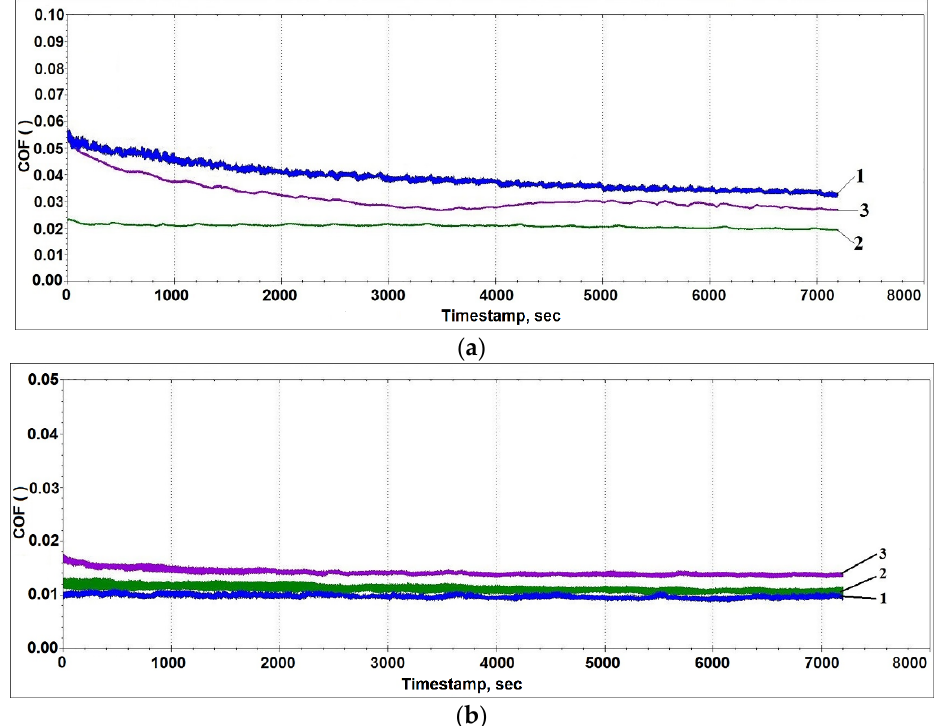
Figure 10. The change in the friction coefficient during the testing of the combined coating made of the AlSi12 alloy with the lead sublayer ( a ) and with the addition of tin ( b ) under different loads: 1—40 N; 2—80 N; 3—120 N.